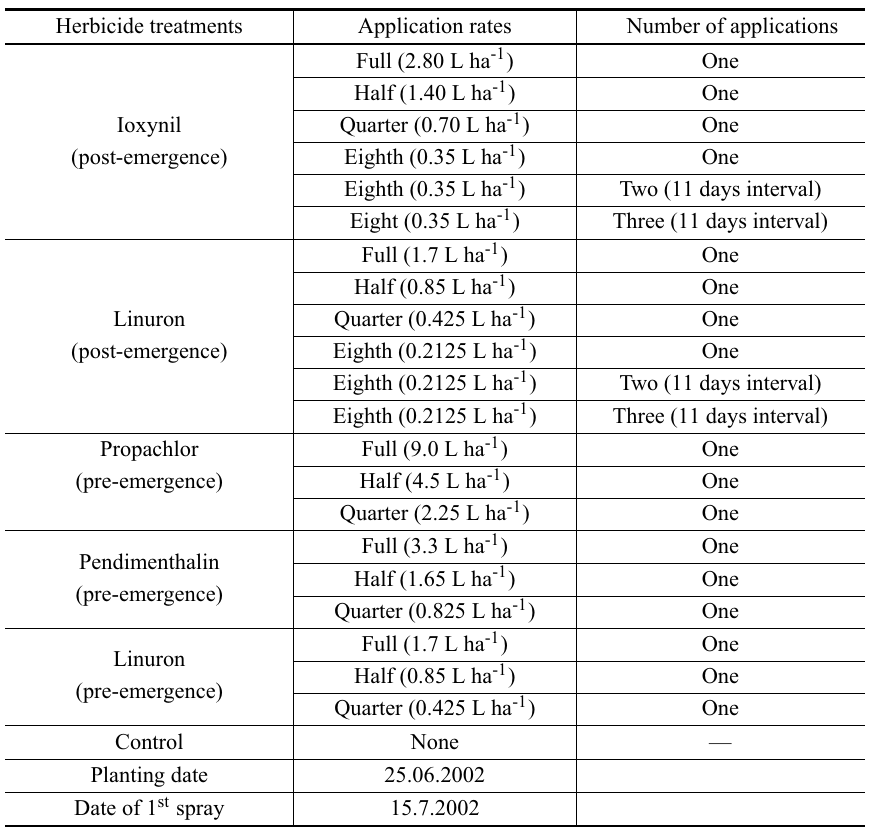
Herbicide treatments for